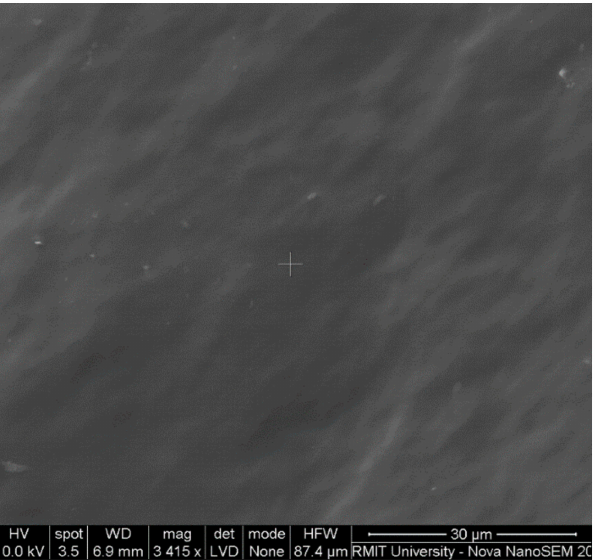
Figure 3. Scanning electron micrograph image of the HPMC:AAc matrix